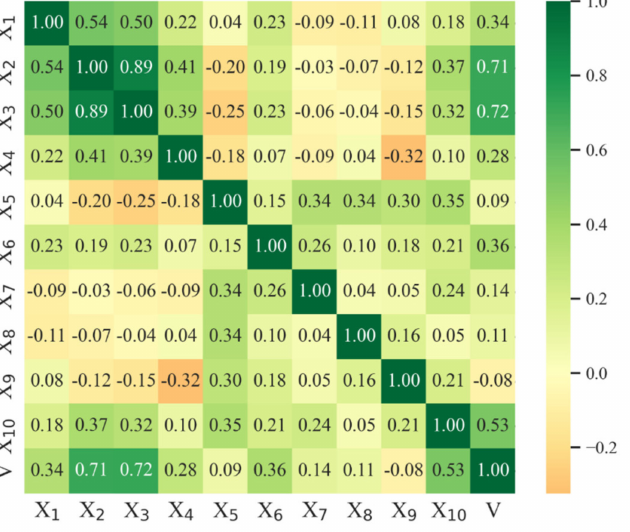
Figure 3. Correlation matrix of input and output